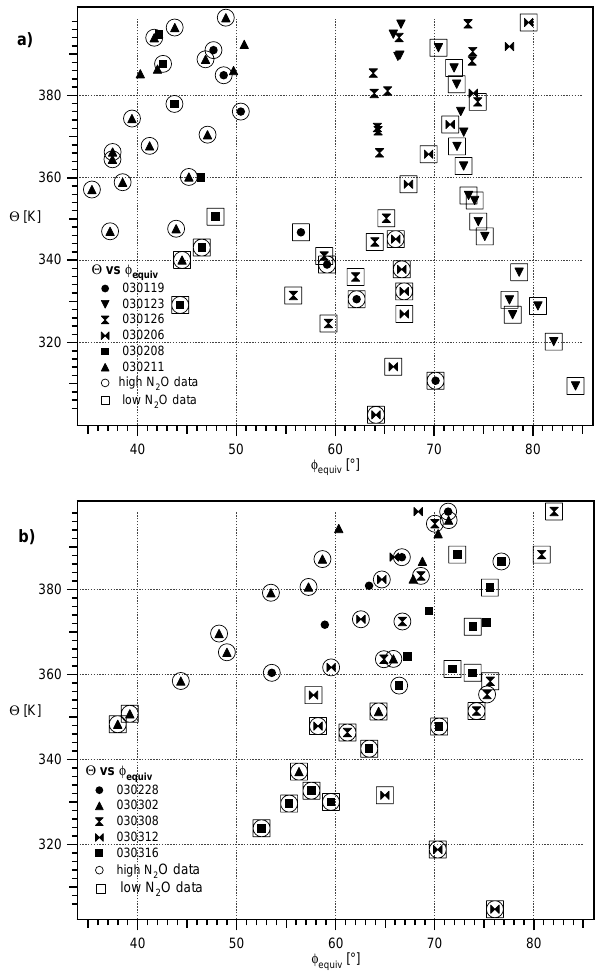
Fig. 10. Potential temperature plotted versus equivalent latitude. (a) Data of the EuPLEx Campaign, (b) data of the AVC campaign. The “low N 2 O data” are highlighted by black squares and the “high N 2 O data” are highlighted by black